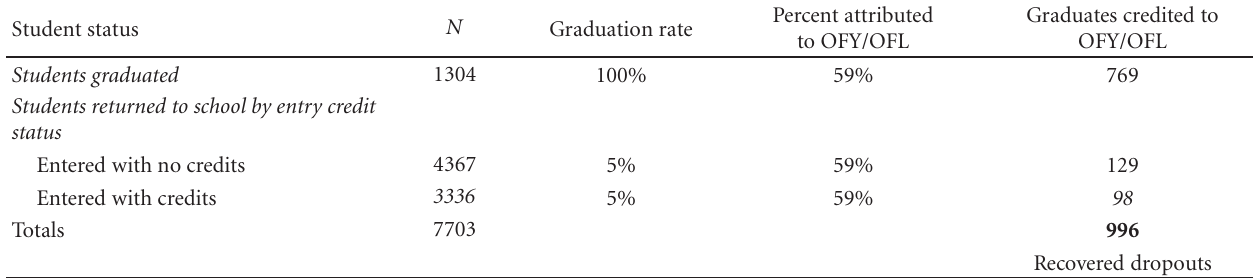
Table 3: OFY/OFL graduates in